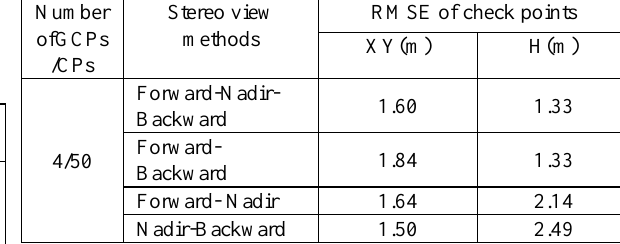
Table 3. The results of Lianyungang mainly covered with hilly